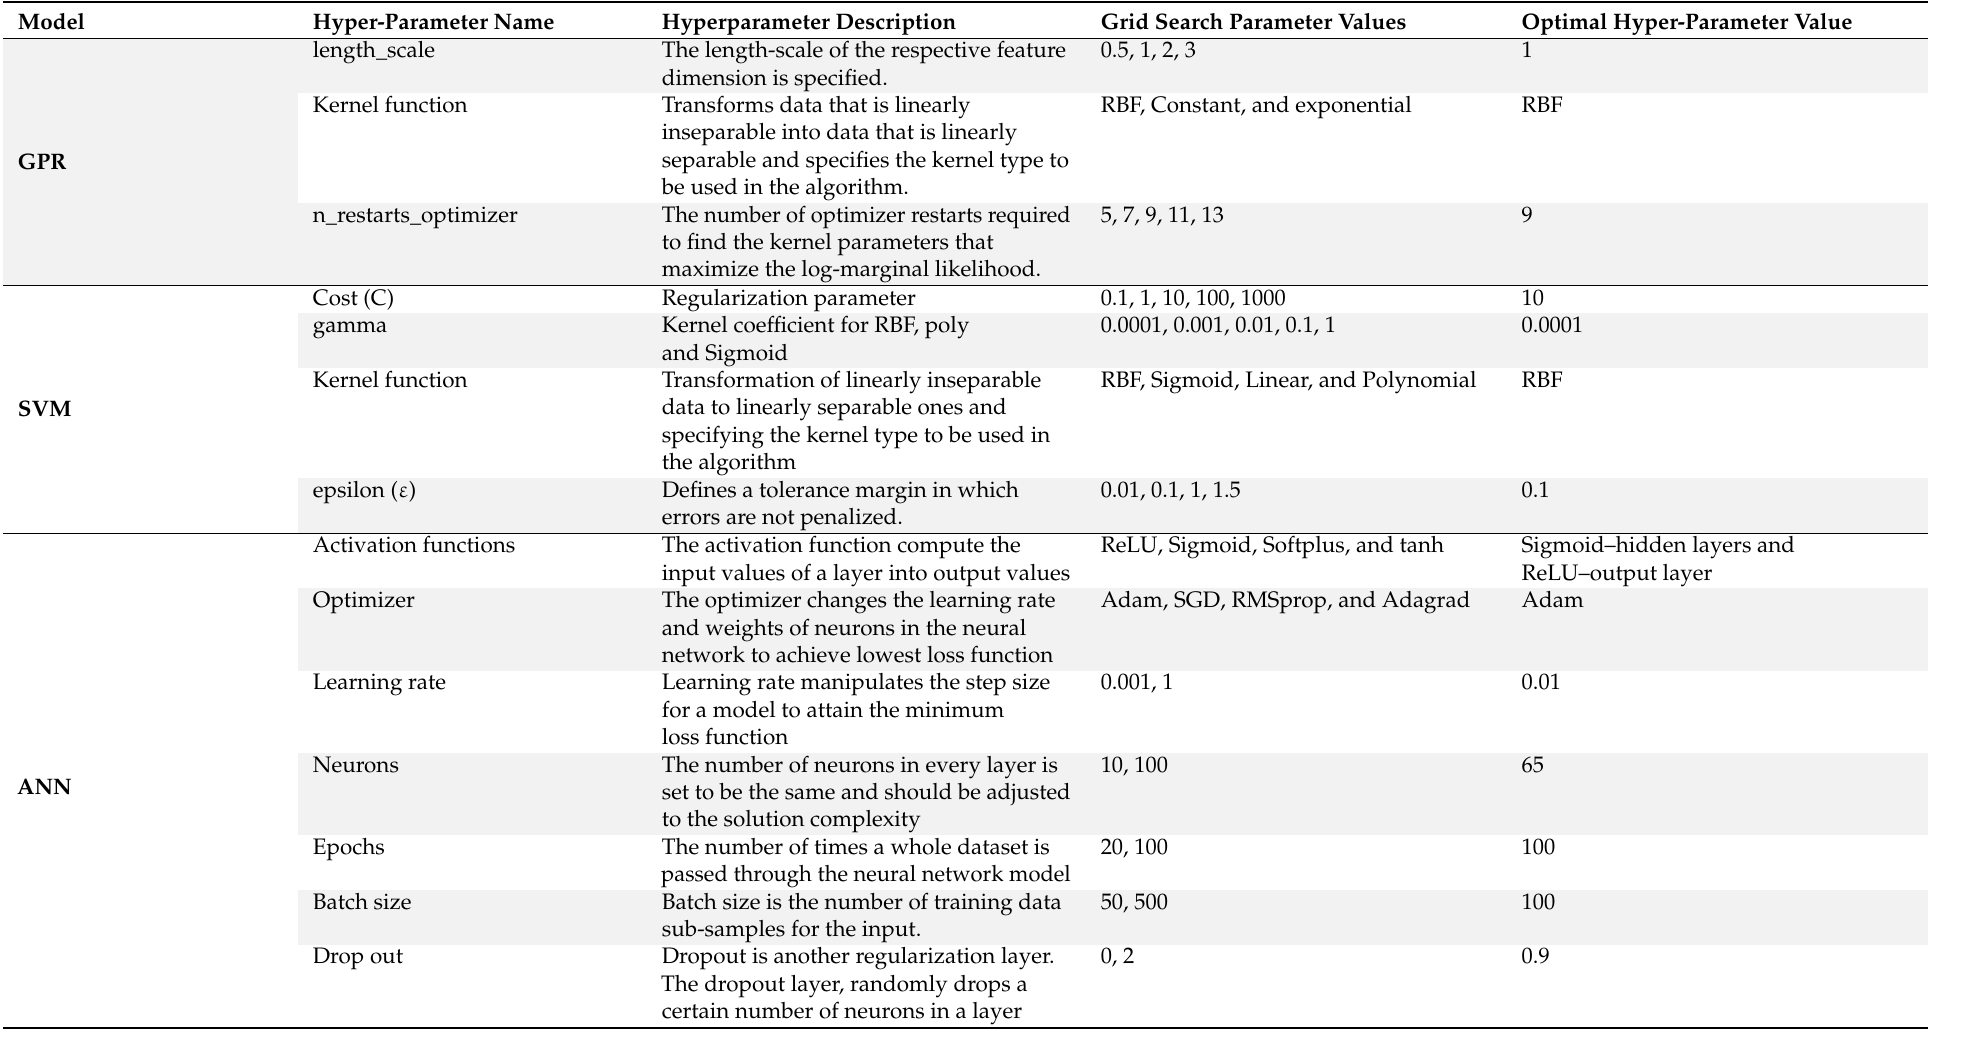
Table 2. Grid-search range of the parameters of each ML/DL method with test values for the hyper-parameters are sorted in ascending